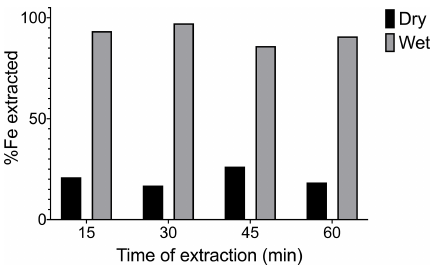
Figure 3. %Fe extracted across a time series for CBD extraction. The sample used in this experiment was a spiked sediment com- prised of 60wt% sediment and 40wt% of a 2 COOH OC–Fe R co- precipitate. Compound maximal instrument error is minimal and can be found in the data